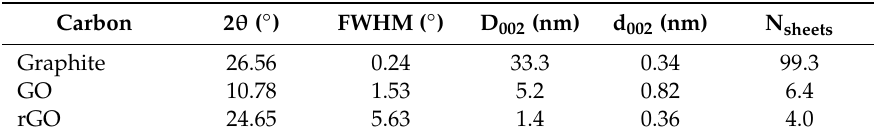
Table 2. Data obtained from XR di ff ractograms on di ff raction peak position (2 θ ), full-width at half maximum (FWHM), interplanar distance (d 002 ), and crystal size (D 002